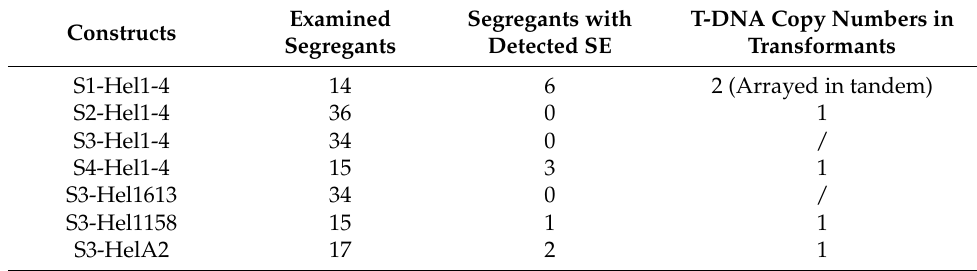
Table 2. Somatic excision activity in F 1 segregants from different c1-dHel-GFP T 2 transgenic